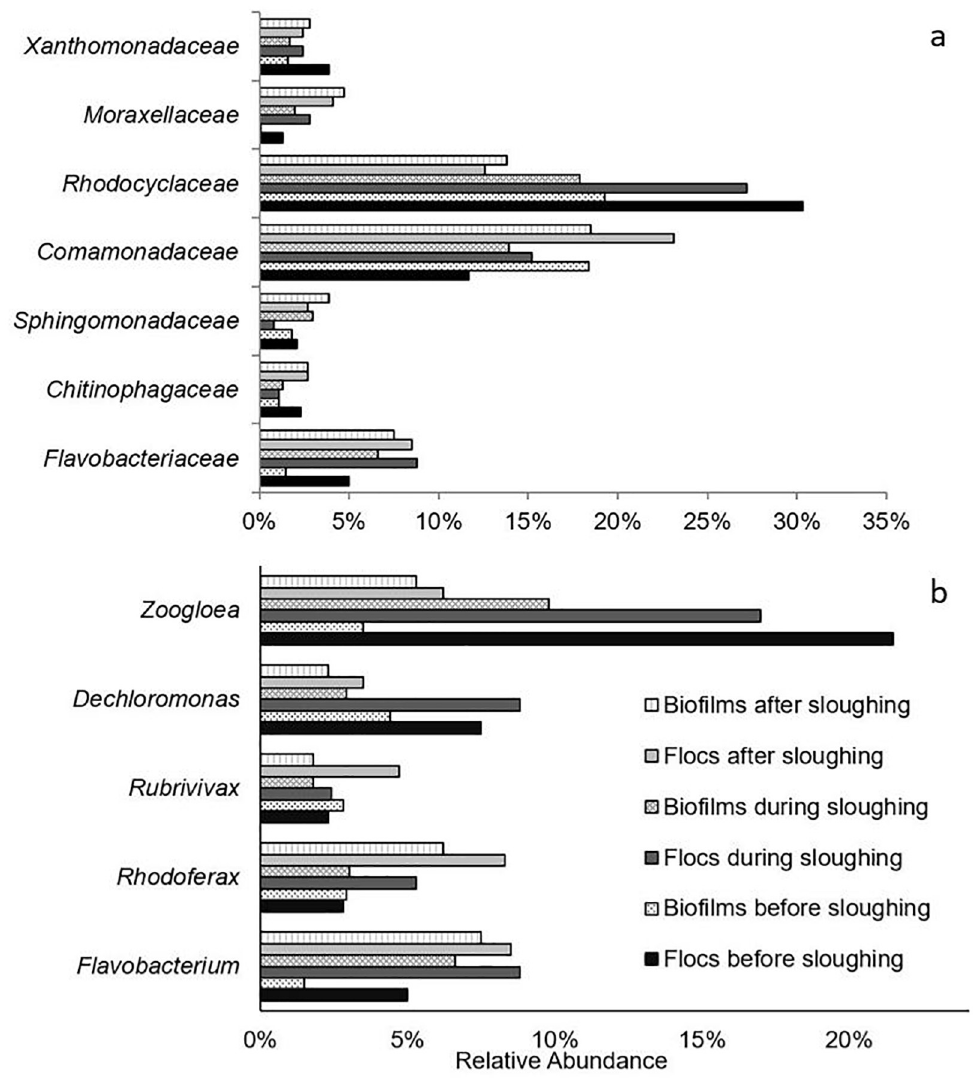
Fig 8. Relative abundance of dominant bacterial groups in biofilms and flocs, before, during, and after biofilm sloughing (a) bacterial families, (b) bacterial genera. X-axis is relative